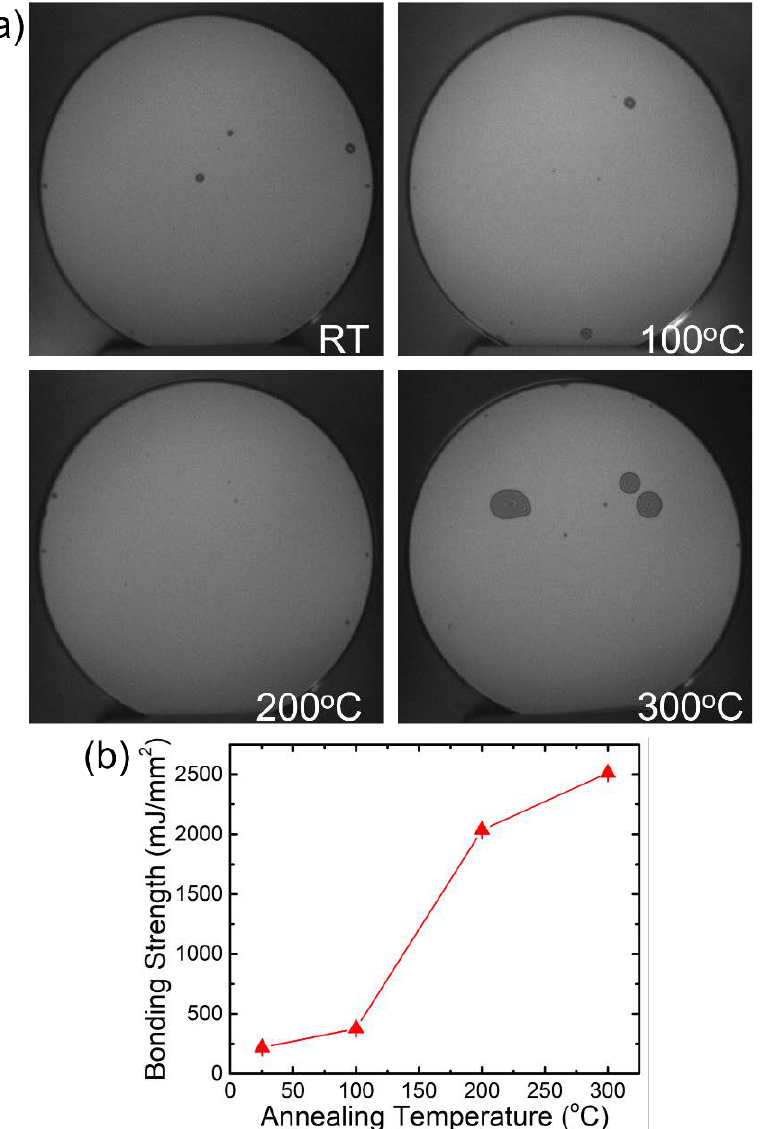
Figure 2. ( a ) IR images for Si-to-Si wafer bonding annealed at different temperatures. Random voids are observed to have greater influences at higher temperatures and ( b ) the corresponding bond strength measurement at the different temperatures.